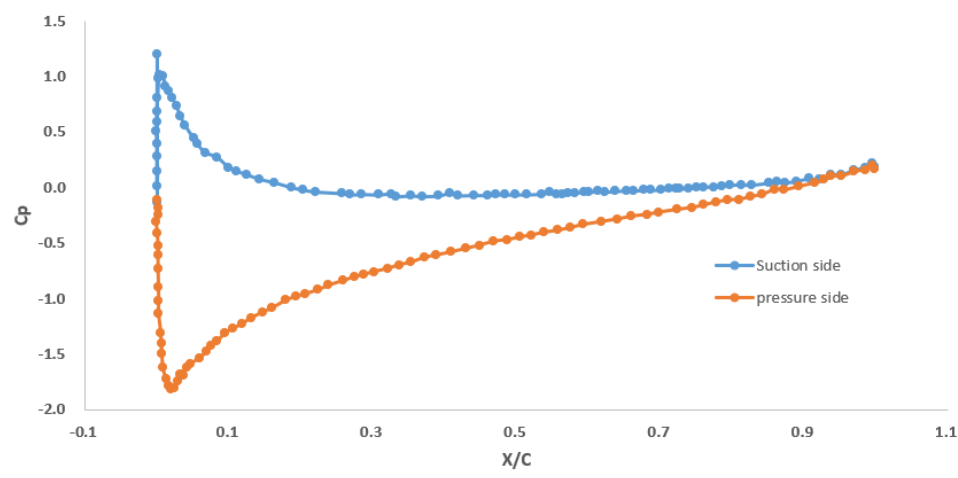
Figure 5. Pressure coefficient on the surface of NACA0012 in the present paper.